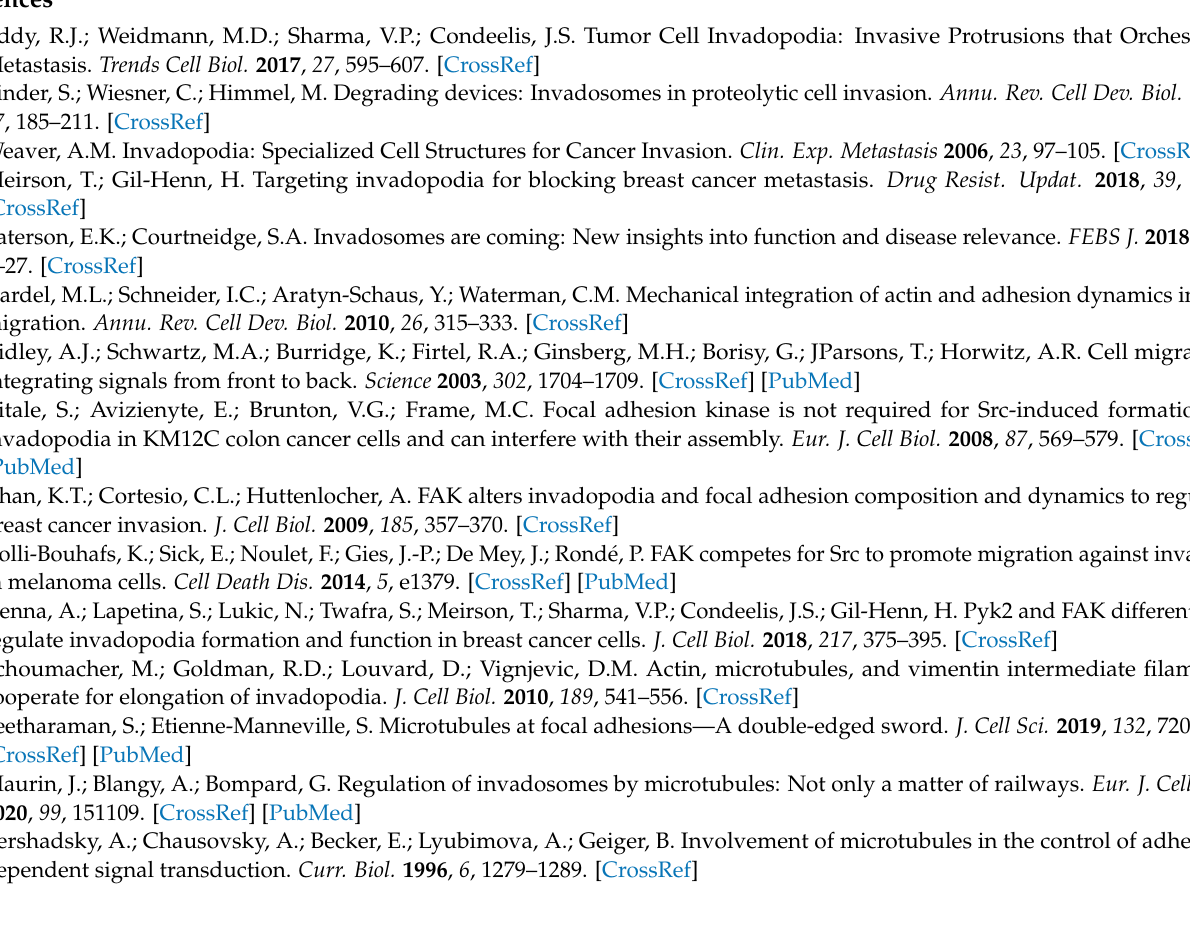
levels, Figure S6: Uncropped Western blots, Table S1: Sequences of siRNAs used in this study, Table S2: Primer pairs used for amplifying FAK, FAK Y397F and EB1